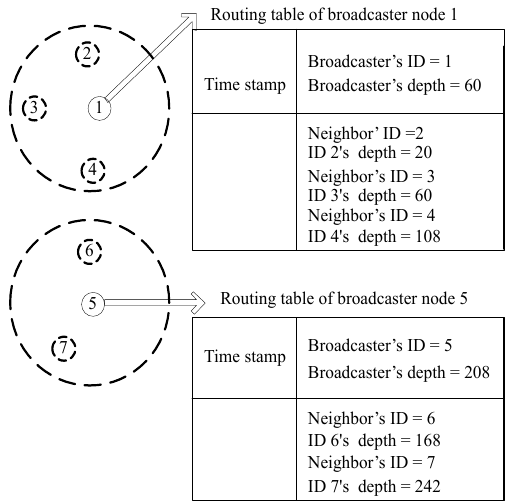
Figure 3. Nodes 1 and 6 create their routing tables and broadcast. Node 1’s routing table is sent to its two hop neighbor, Node 7, via its neighbor Node 4. Node 6’s routing table is sent to its two hop neighbor, Node 4, via its neighbor Node